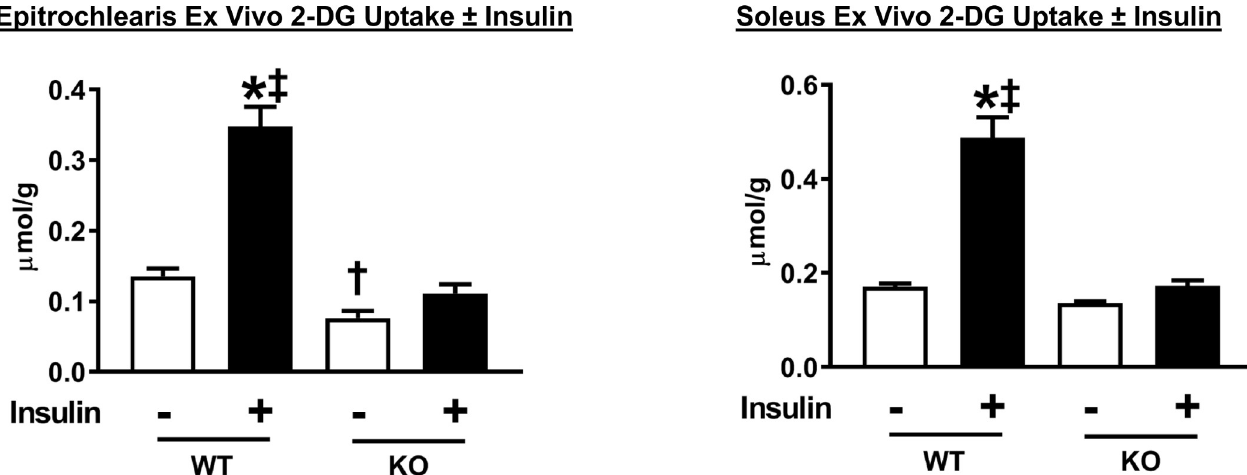
Fig 10. 2-Deoxyglucose (2-DG) uptake by isolated epitrochlearis and soleus muscles from WT and KO rats. Paired muscles were incubated in the absence (white bars) or presence (black bars) of insulin (500 μ U/ml). Data were analyzed by two-way ANOVA, and Holm-Sidak post hoc analysis was used to identify the source of significant variance. � P < 0.001, without insulin versus insulin of the same genotype; ‡ P < 0.001, WT versus KO with the same insulin dose; † P < 0.05, WT versus KO with the same insulin dose. A t-test revealed significantly greater glucose uptake with insulin versus without muscle in soleus (P < 0.05). A non-significant trend (P = 0.05) for an insulin-stimulated increase was found with a t-test in epitrochlearis. Means ± SEM for 8–9 rats of each genotype.